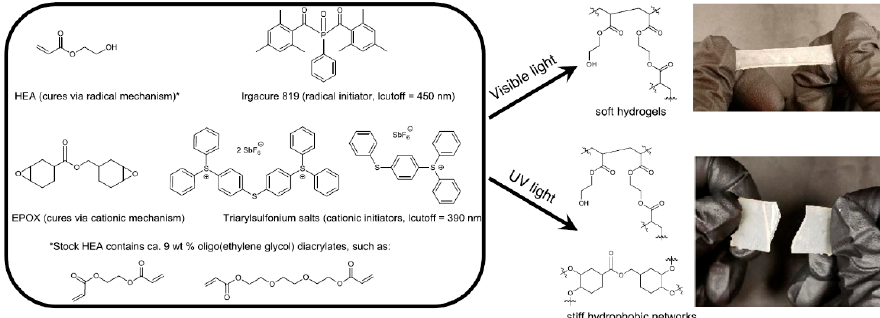
Figure 32. Representation of MASC strategy to achieve different networks with discrete wavelengths of light irradiation. A stiffer network was formed by cationic epoxy polymerization, while a softer network was generated by radical acrylate polymerization. Reproduced from [320].